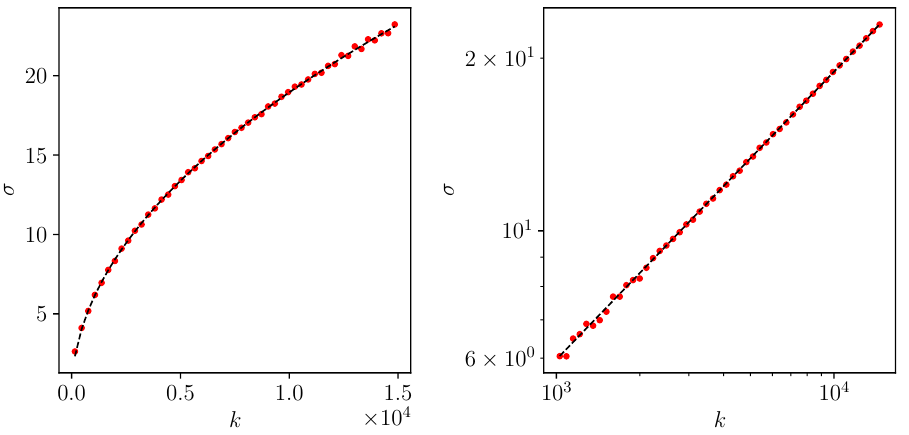
Figure 7. The standard deviation σ of the distribution of the fluctuation quantity w ( k ) = R ( k ) = ( k ) W ( k ) for a wide range of k , shown along with the fitting curve, σ = a k γ , with a = 0.187 and N − γ = 0.502: in the linear scale ( left panel) and in log-log scale (right panel) . The log-log plot clearly shows a power-law increase of k with the slope